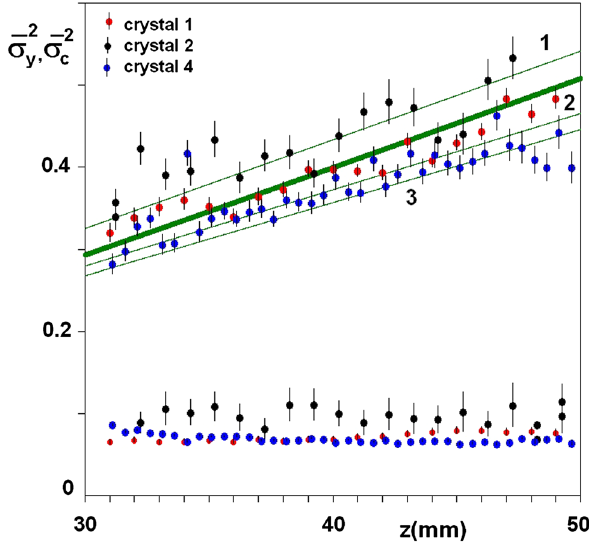
Fig. 7 The mean square values ¯ σ y 2 = κ 2 σ 2 y , ¯ σ c 2 = κ 2 σ 2 c (where coefficient κ = E 0 [ MeV ] 10 6 / 13 . 6) as dependences of the crystal thickness. The solid thick curve represents the value κ 2 σ 2 (see also 0 Eq. (4)). The dependences were obtained for all the crystals at condi- tion with the background corrections. The lines 1, 2 and 3 are drawn with accordance of Eqs. (7) and (8) at boundary values of parameters = 92 , 106 , 112 mm, corre- A = 13 . 72 , 12 . 78 , 12 . 42 MeV and X ∗ 0